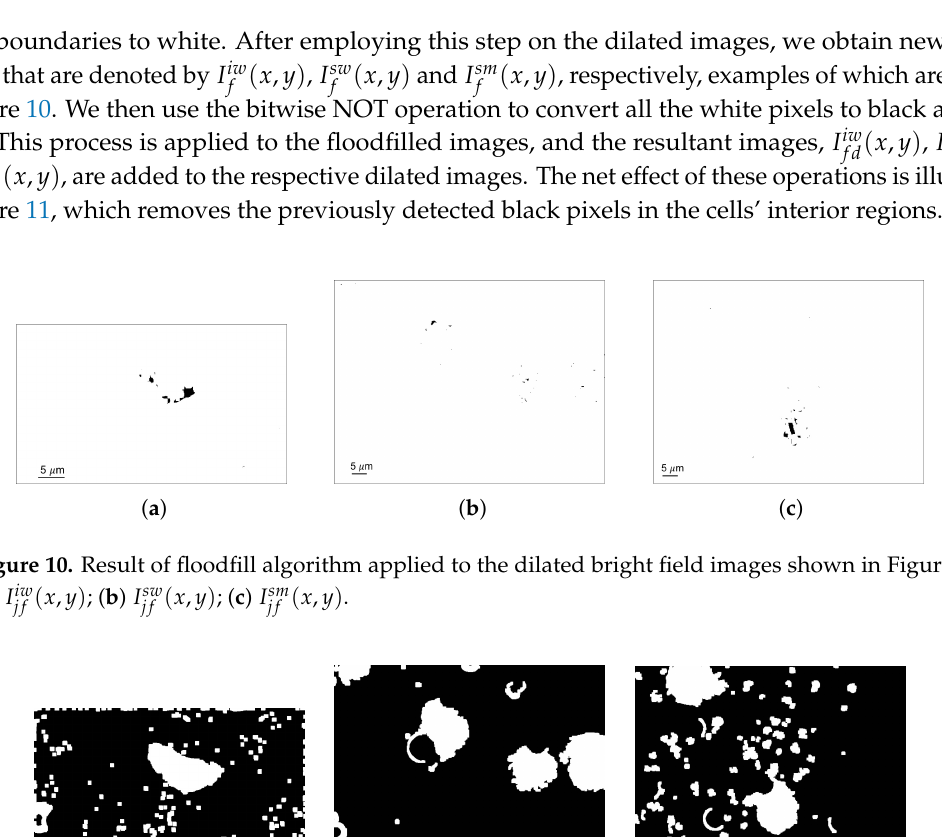
( x , y ) ; ( b ) I sw ( x , y ) ; ( c ) I sm ( x , y ) . jfd jfd jfd